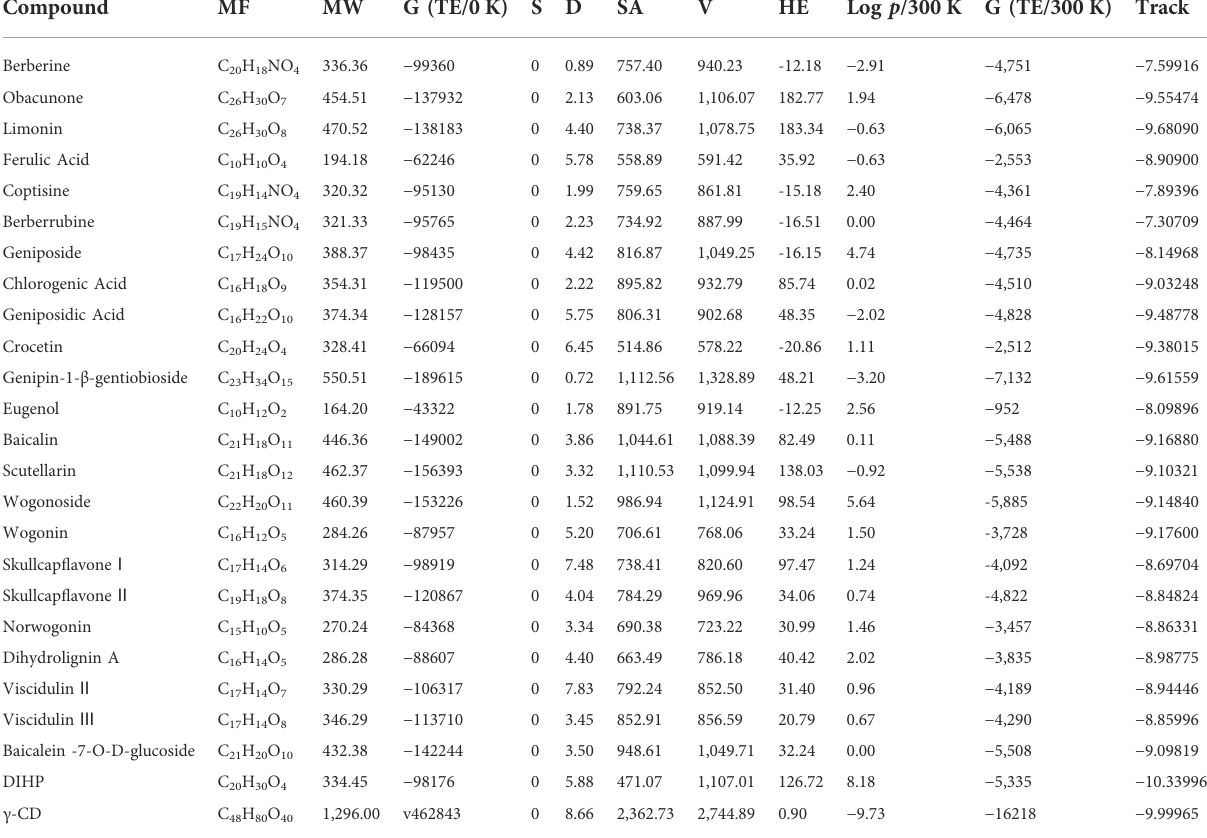
TABLE 5 Molecular parameters calculated before self-assembly of γ -CD by bitter compounds in